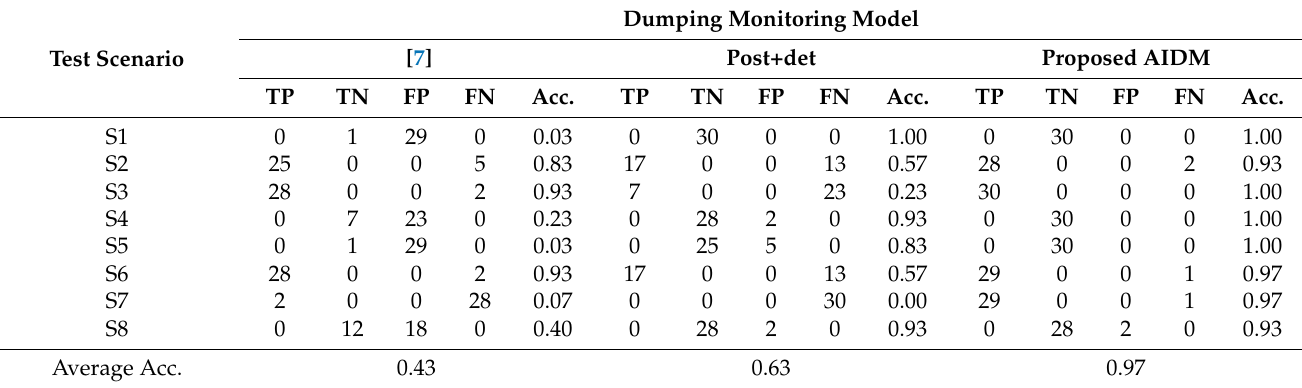
Table 2. Performance comparison of dumping monitoring models per